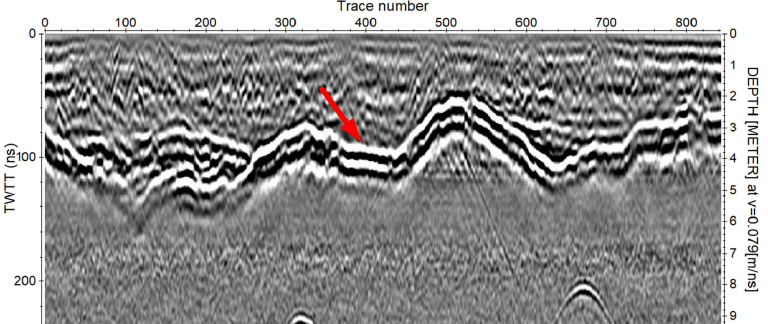
Figure 5. Processed radargram of ground ‐ penetrating radar section with reflection of the active layer marked by an arrow. TWTT: two ‐ way travel time. marked by an arrow. TWTT: two-way travel